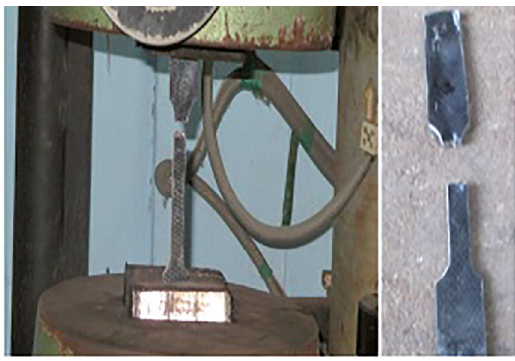
Figure 3: Tensile test (a) UTM setup, (b) specimen after fracture